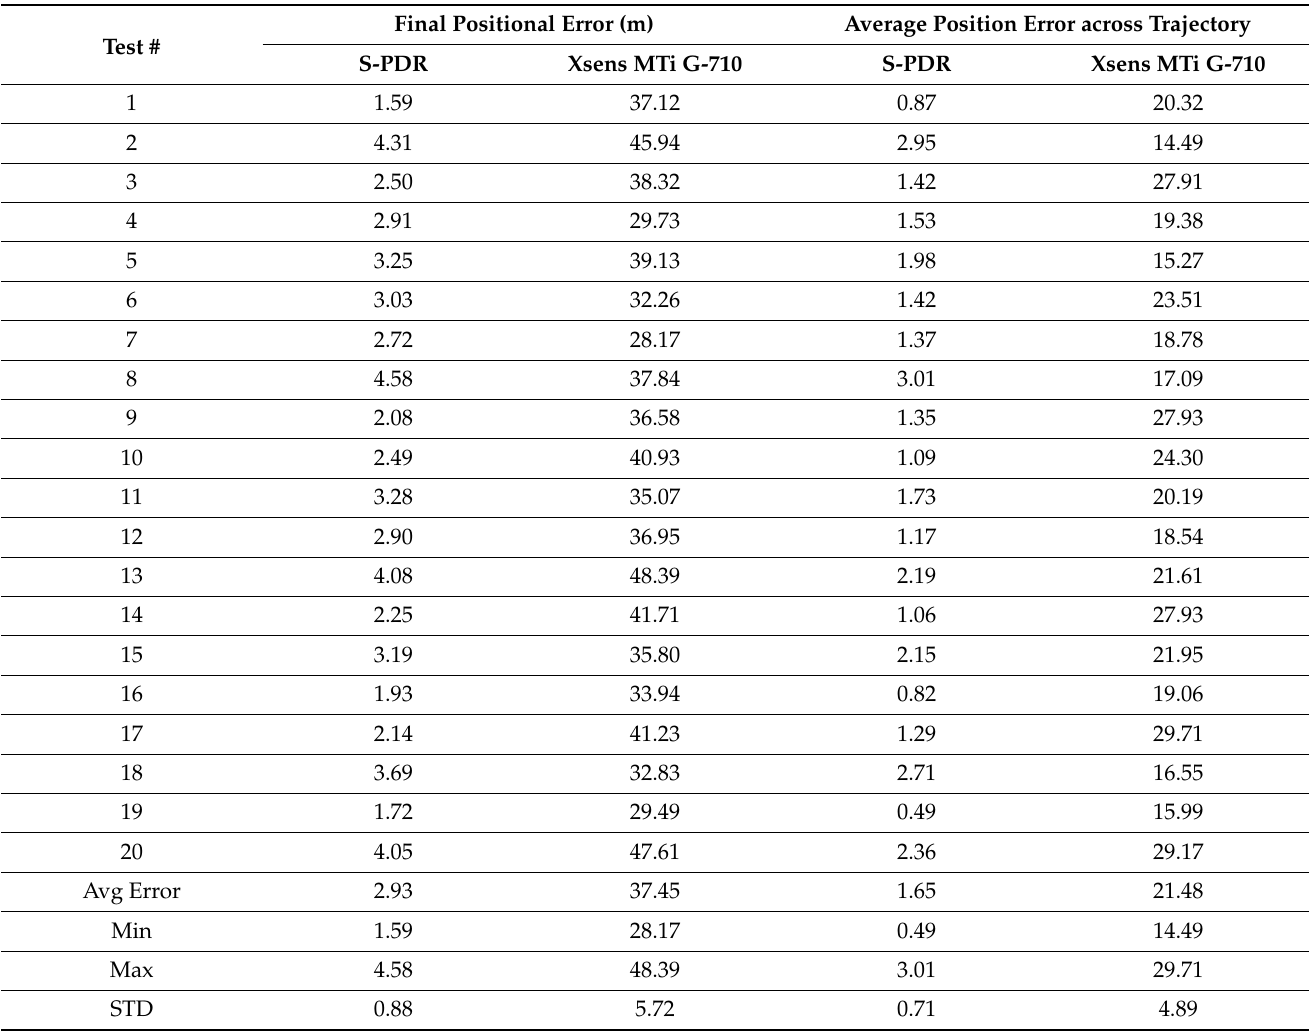
Table 3. Test results for outdoor loop